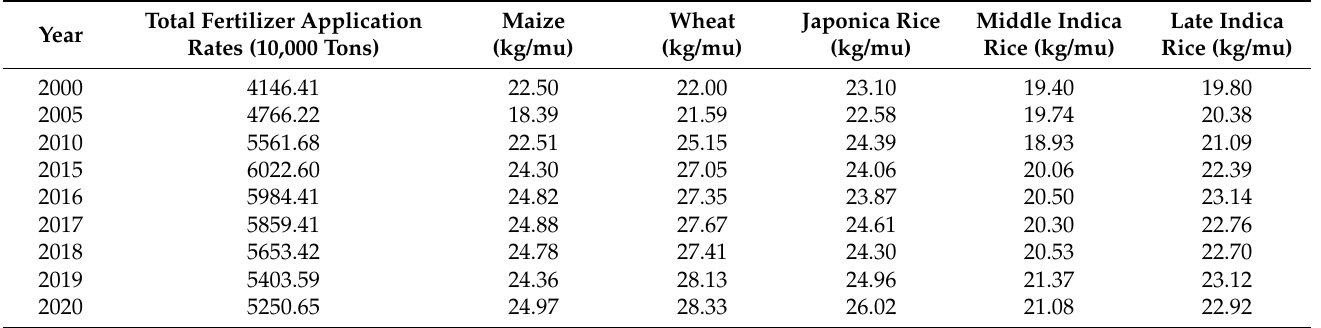
Table A1. Total fertilizer application rates and fertilizer application rates (the pure amount of fertilizer per mu) of different crops in